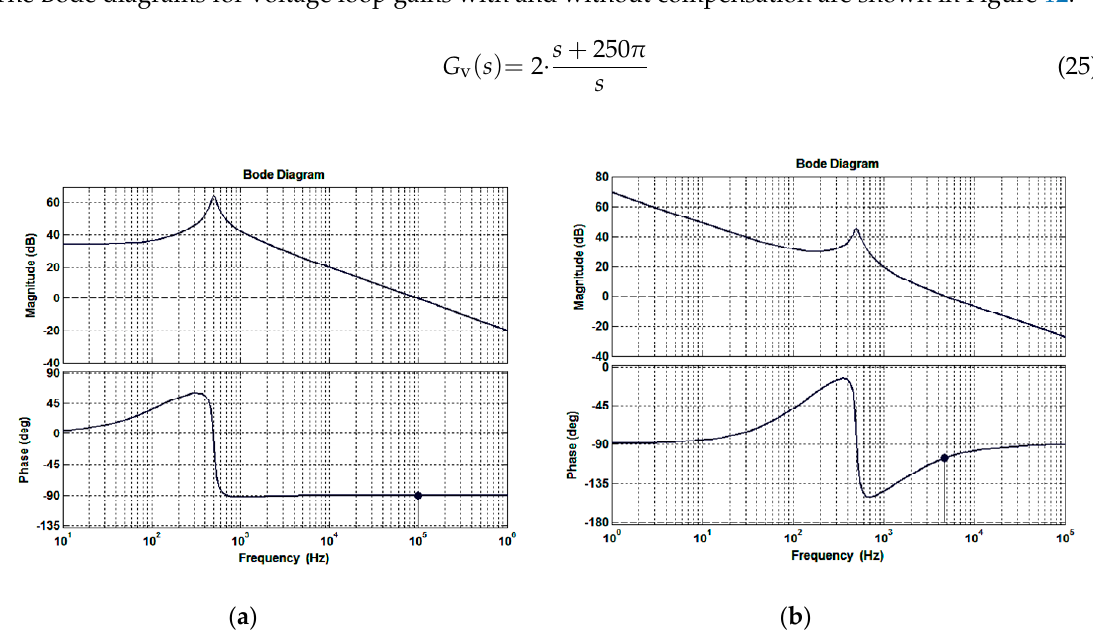
Figure 11. Frequency characteristic of the current loop gain: ( a ) without compensation ( b ) with compensation.